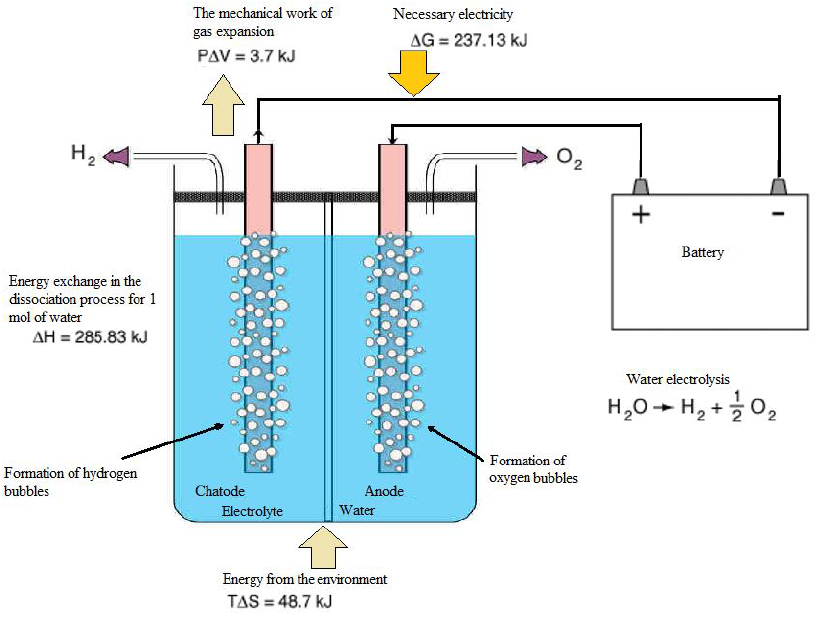
Figure 7. Energy balance in water electrolysis [9].